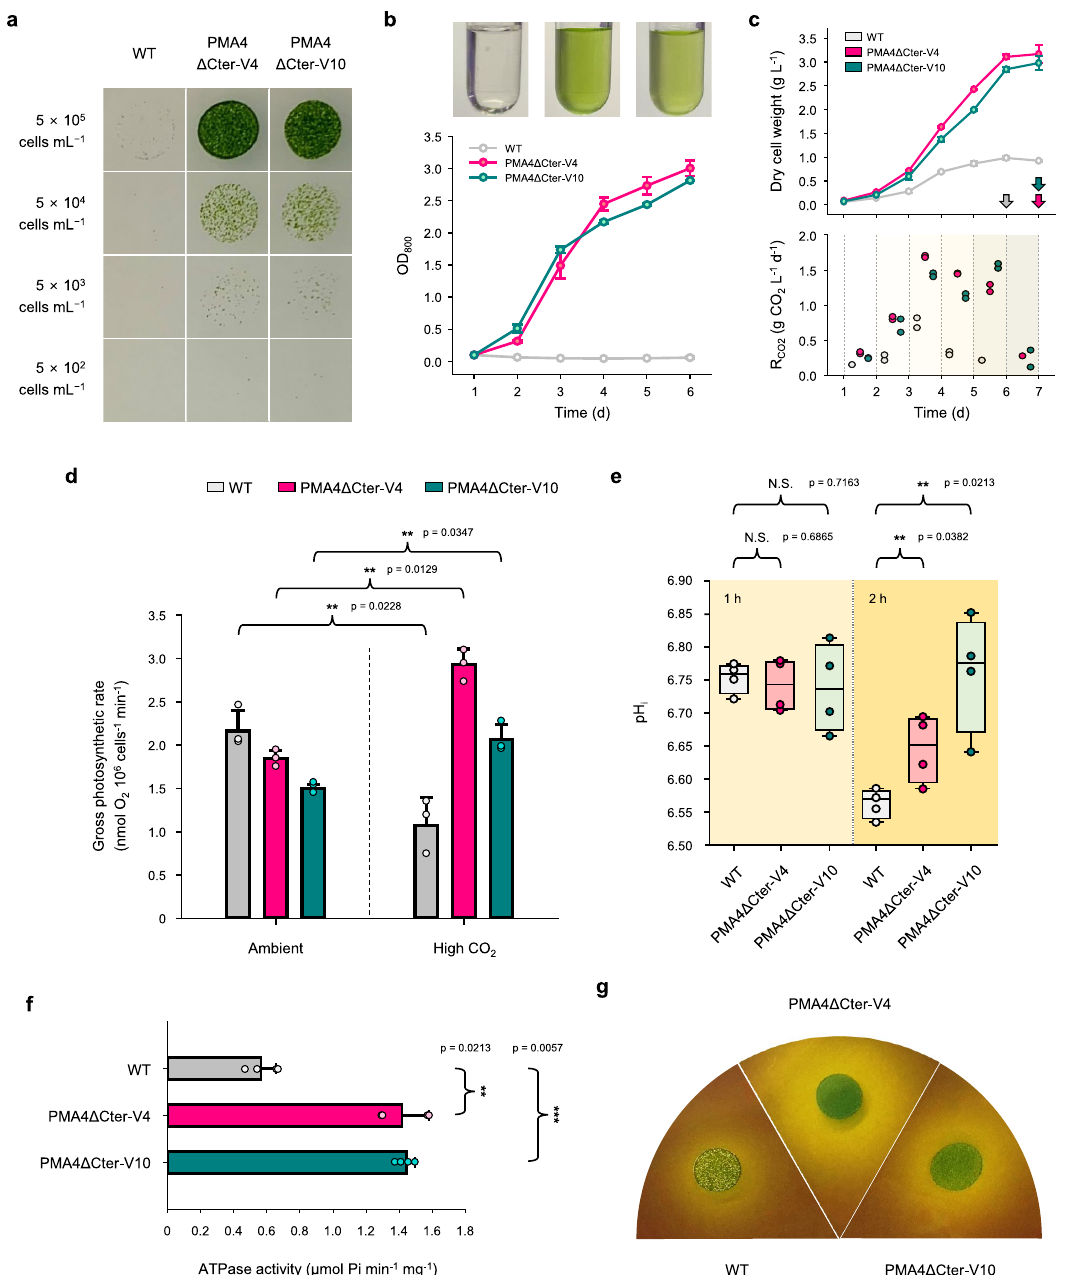
Fig. 3 Cell performance of the transgenic strains compared with the WT strain. a Spot culture with serial dilution on agar medium (supplemented with acetic acid) at pH 5.5. b The pH tolerance during liquid cultivation (pH 5.5; supplemented with acetic acid) is markedly enhanced via PMA4 Δ Cter expression. Shown are data from duplicate cell culture. The cell states at Day 2 of WT, PMA4 Δ Cter-V4, and PMA4 Δ Cter-V10 are displayed from the far left of the top panel. c The photoautotrophic biomass production (upper panel) and CO 2 fi xation rate (R CO2 ; lower panel) are improved under extremely high CO 2 conditions (20% CO 2 ). The two graphs share the same timescale. The arrows indicate the time points (distinguished by the colors) that the cell lines reached their maximum concentrations. Data from duplicate cell cultures are shown. Each dot in the lower panel depicts two biological replicates. d Per-cell gross photosynthetic rate of the strains exposed to high CO 2 . The parameter was estimated as light-dependent O 2 evolution plus dark respiration. The double asterisks indicate statistically signi fi cant differences in the gross photosynthetic rate of each strain under the high CO 2 environment compared with those under the ambient conditions ( p < 0.05). Each bar represents the mean ± SD of three independent experiments. e Box and whisker plots demonstrating the pH i of the microalgal strains exposed to high CO 2 conditions derived from four biological replicates. The median (the center line) ± whiskers (1.5× the interquartile range from the lower and upper quartiles) with the interquartile range (the boundaries) are provided. The double asterisks indicate statistically signi fi cant differences compared with the pH i of the WT strain after 2 h of exposure to CO 2 ( p < 0.05). N.S. represents not signi fi cant. f In vitro ATPase activity assay using isolated PM-enriched fraction samples. The double ( p < 0.05) and triple ( p < 0.01) asterisks denote statistically signi fi cant differences compared with the ATPase activity of the WT strain, respectively. Each bar represents the mean ± SD of four independent experiments. In d , e , and f , the statistically signi fi cant differences were determined by a two-tailed Student ’ s t test. g Representative image of bromocresol purple-mediated in vivo ATPase activity test. Source data are provided as a Source Data fi